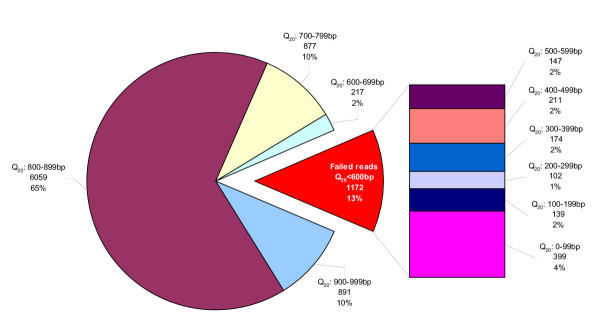
Average read length breakdown Distribution of read length (Q20 bases) for full data set of 9,216 reads. Results were divided into 100 bp bins, failed reads (Q20<600 bp) make up 13% (1,172 reads) of overall reads. Reads with Q20<100 bp make up the largest proportion of failed reads but contributes to only 4% of overall data set.